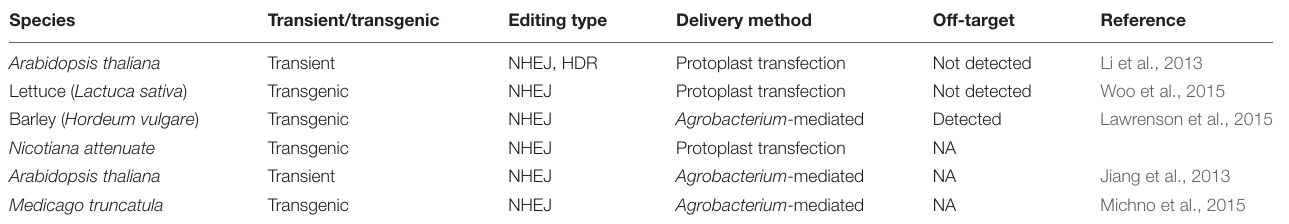
FIGURE 5 | Strategy of developing disease free plants using gene editing tools. TABLE 2 | Genome editing in different plant species by the CRISPR/Cas